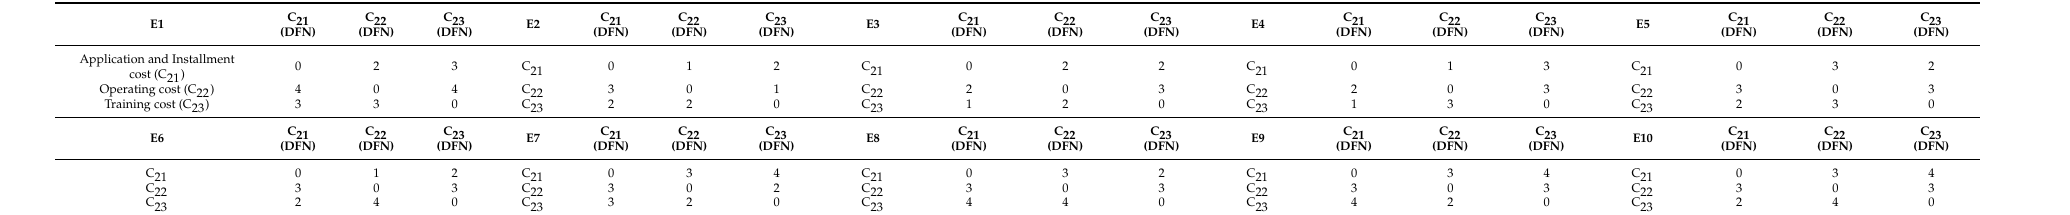
Table A3. Degree of direct fuzzy influence between Economical (C 2 )